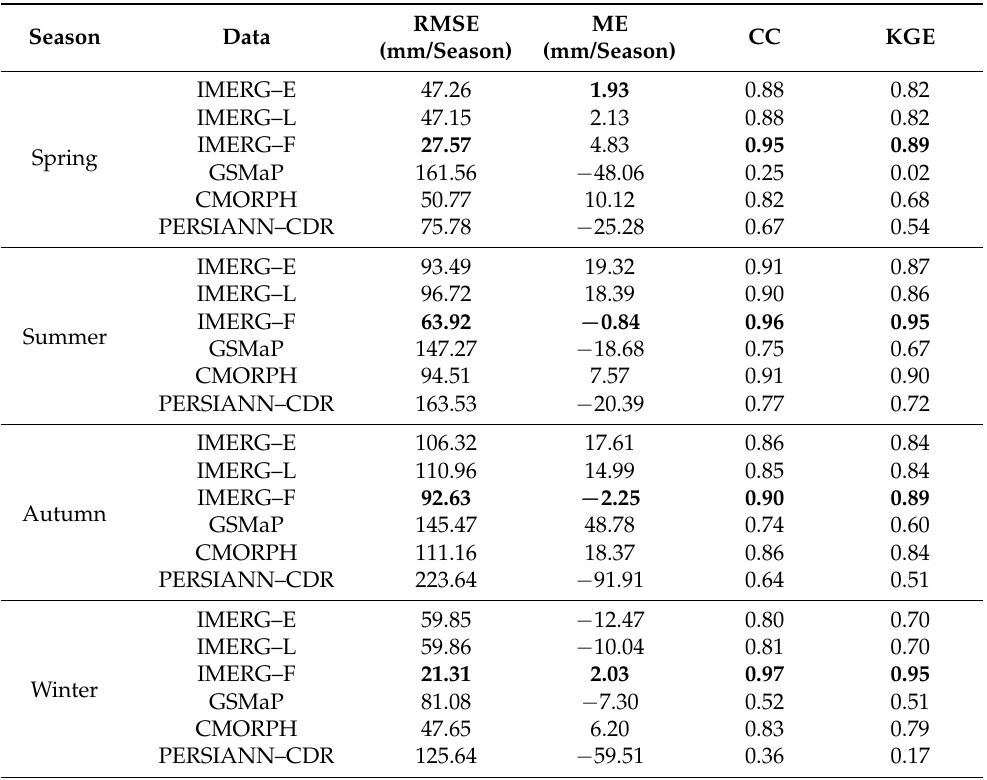
Table 5. Seasonal precipitation statistics of the six satellite precipitation products over mainland China from 2001 to 2015